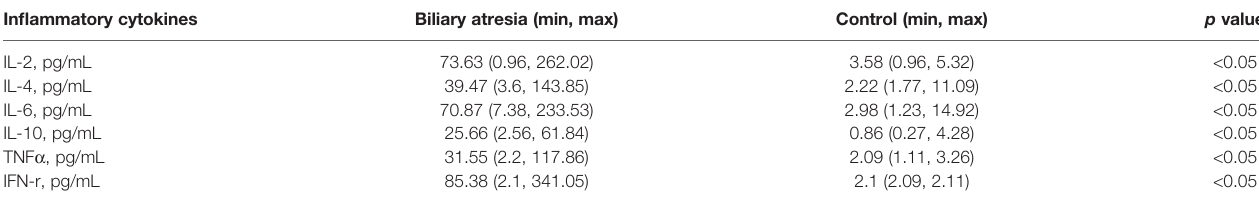
TABLE 2 | Results of cytokines between the control and biliary atresia